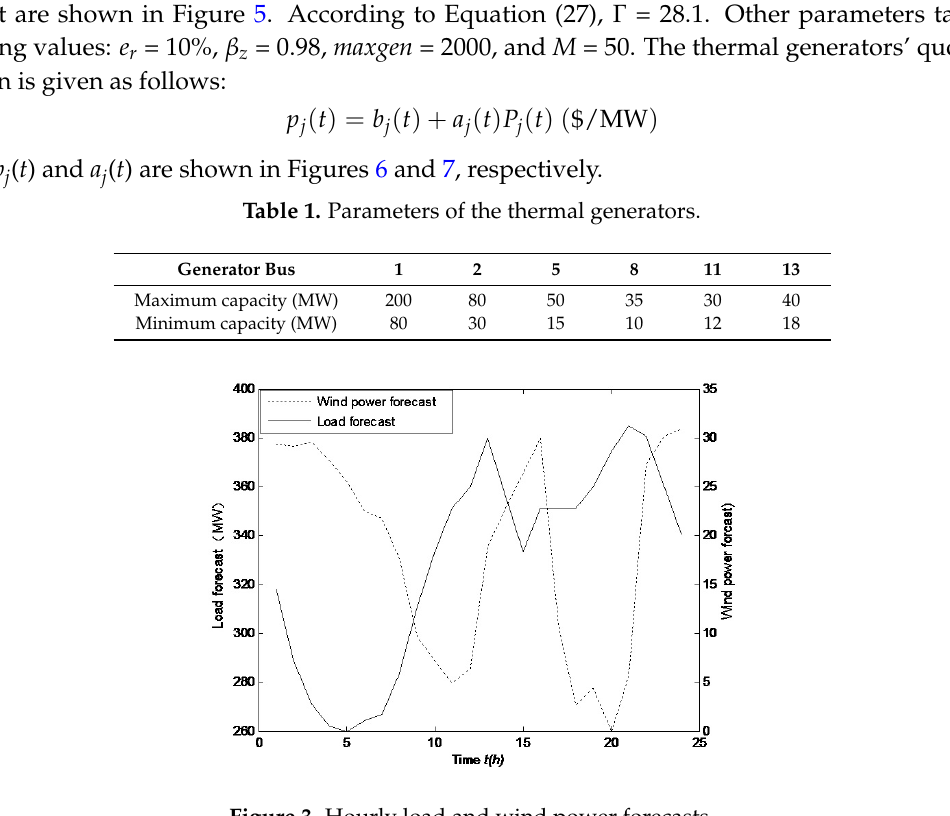
Figure 3. Hourly load and wind power